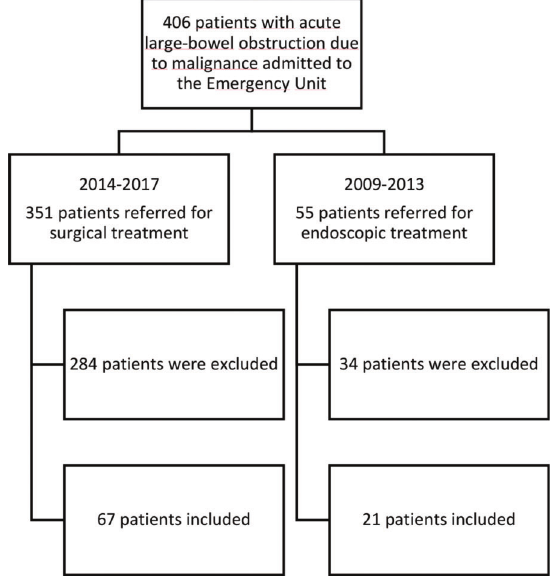
Figure 1 - Flowchart of patient selection.